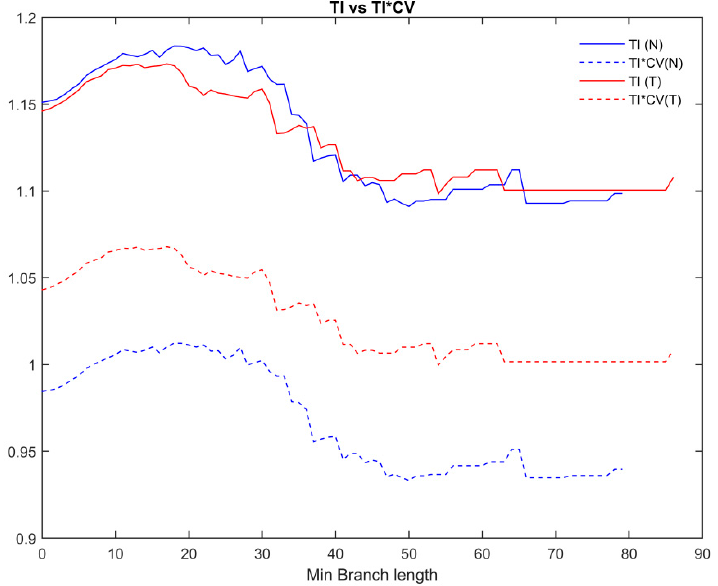
Figure 5. The proposed index TI*CV (dashed line) compared to the conventional TI (solid line). T (tortuous) retinal indexes are plotted in red, N indexes in blue.